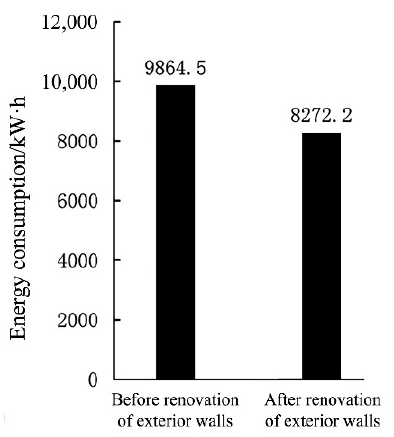
Figure 18. The simulated temperature of the master bedroom before and after renovation of exterior walls.